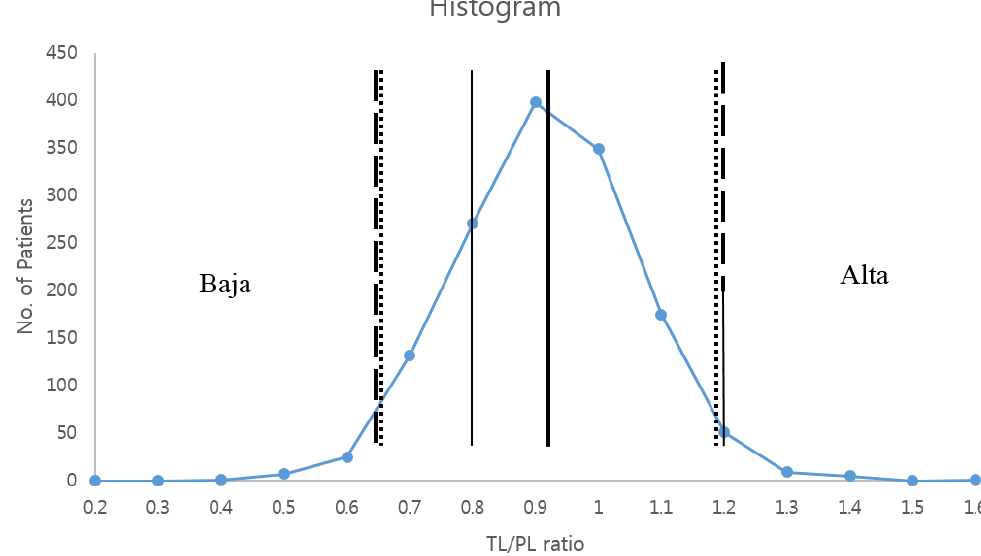
Figure 2. The distribution of the Insall–Salvati index (ISI) for the whole sample: a symmetrical curve; the thick solid line shows the mean (0.92), the thin solid lines show the normal range from the previous study (0.8, 1.20) [9], the broken lines show the normal range using 2 SD from the mean (0.64, 1.20), and the dotted line shows the normal range using the extreme 2.5% at each end of the distribution (0.65, 1.19).